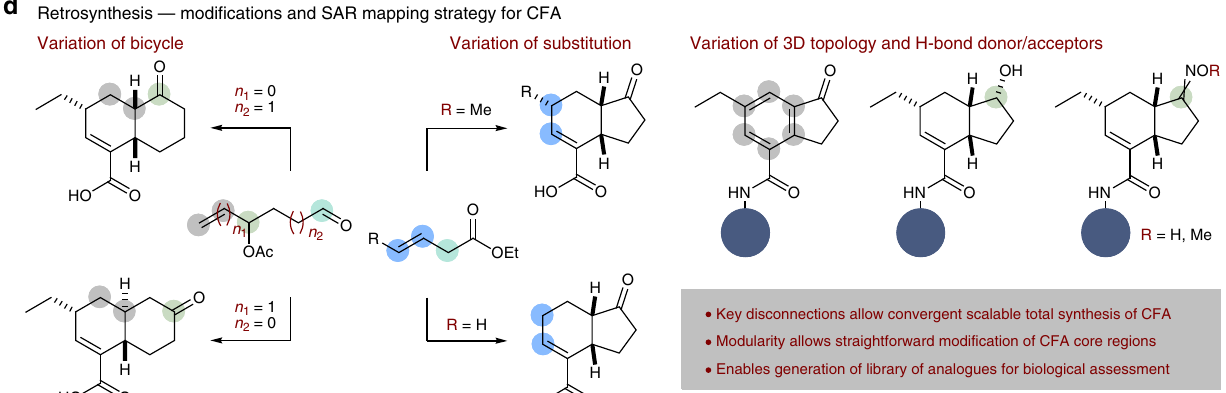
Fig. 1 Structure, current SAR and route design plan for ( + )-7- iso -JA- L -Ile (JA-Ile) and coronatine ( 1 ). a Structural similarities between the natural bioactive ligand JA-Ile and 1 are highlighted. Coronatine can be considered as comprising of two component parts; the bicyclic core, coronafacic acid 2 , amino acid moiety, and coronamic acid 3 . b , c A summary of the known SAR at the outset of this work. d Retrosynthesis and route design plan for SAR